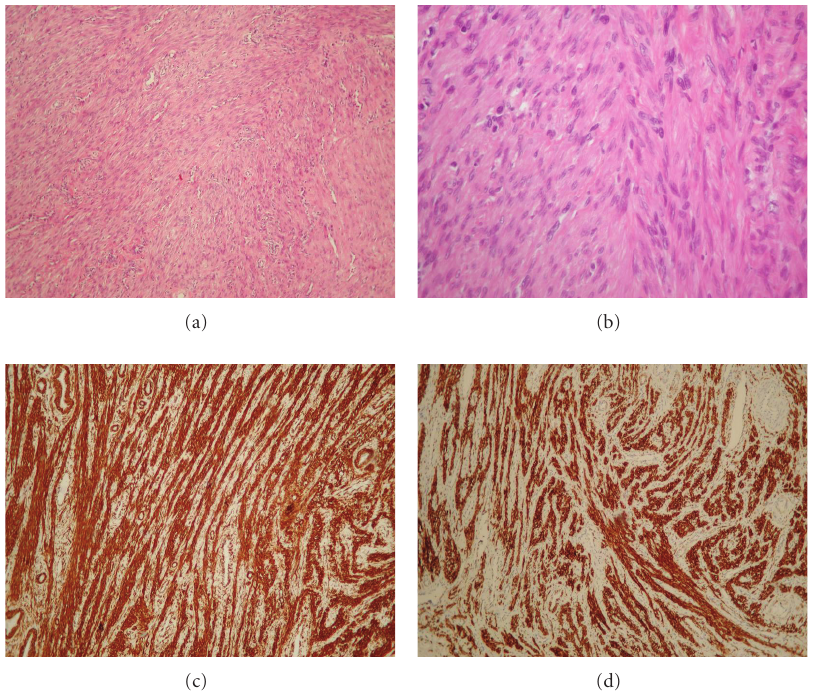
Figure 3: Microscopic features of the largest nodule (of 13 cm in diameter). (a) Spindle cells arranged in interlacing bundles, within a collagenous stroma (H+E, × 200). (b) The cells have vesicular relatively uniform nuclei (H+E, × 400). (c) Leiomyomatous cells express SMA (DAB × 200). (d) Leiomyomatous cells express desmin (DAB ×